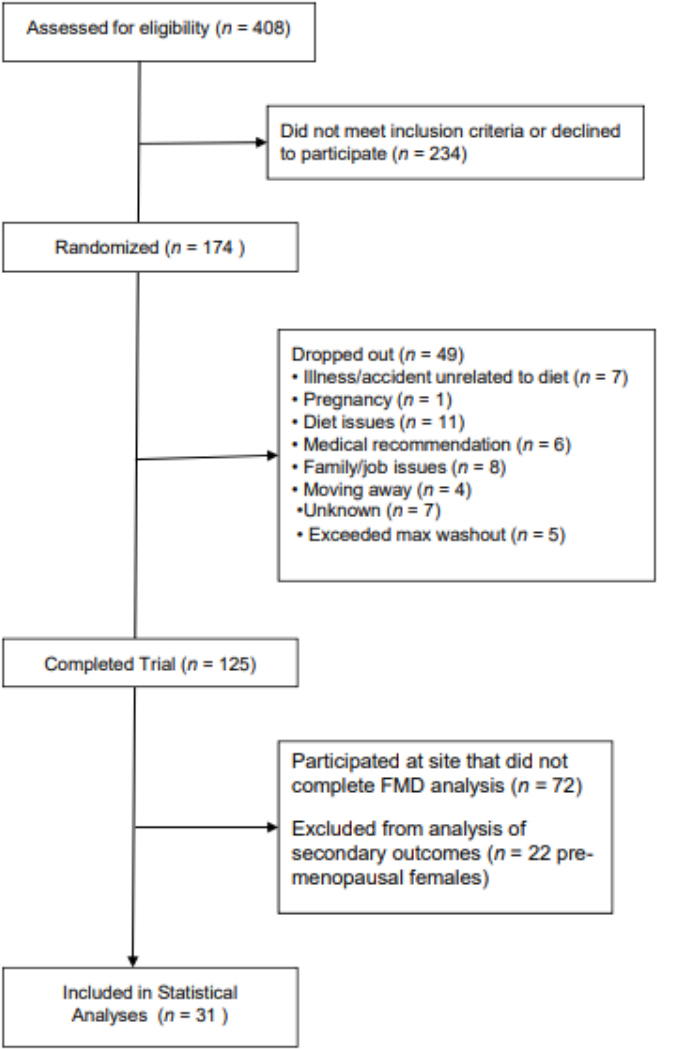
Figure 1. CONSORT participant flow diagram of the COMIT-2 participants for inclusion in the flow-mediated dilation analyses. COMIT, Canola Oil Multi-Centre Intervention Trial; max, maximum; FMD, flow-mediated dilation.